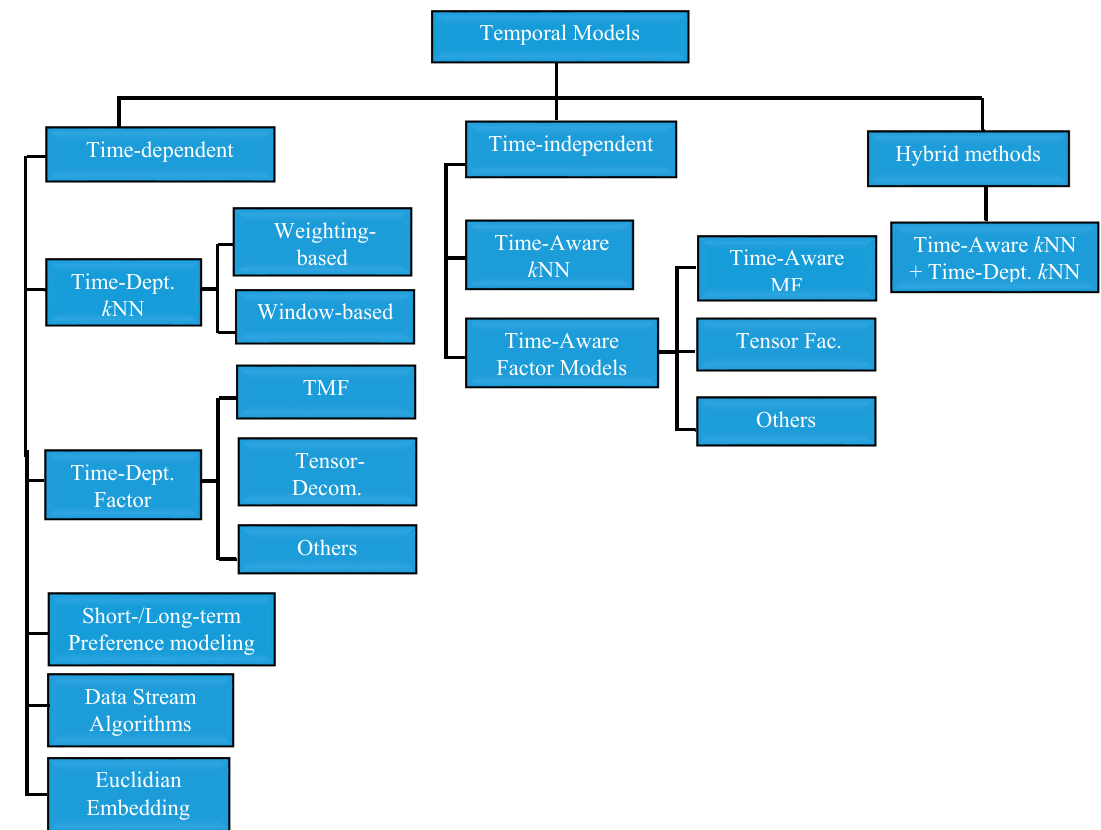
Figure 6. Categories of temporal models for handling temporal dynamics in recommender system (RS).